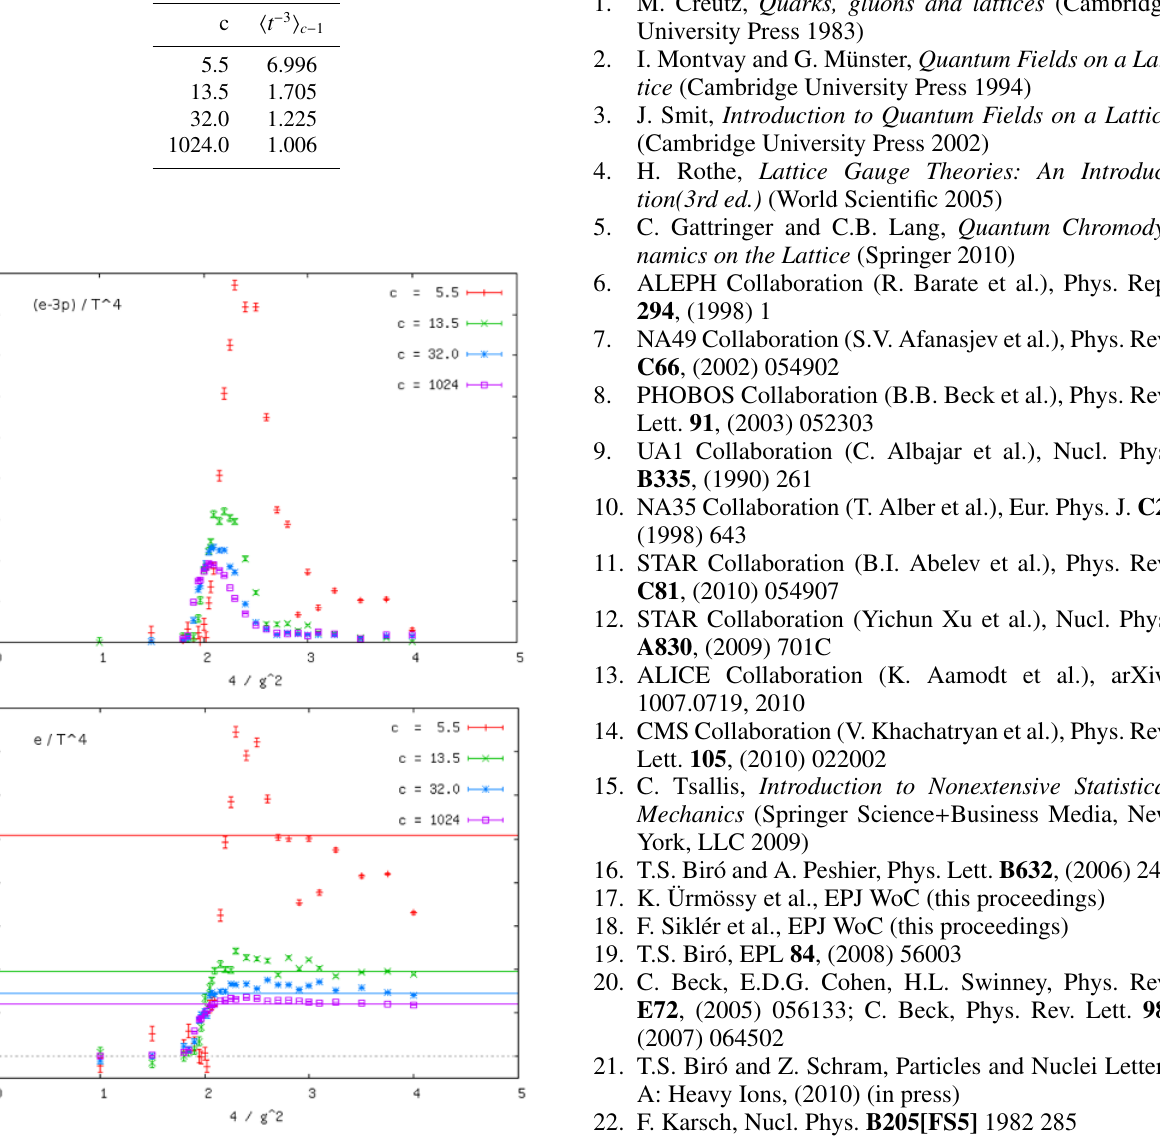
Table 1. Factors in the Stefan-Boltzmann relation for the free Tsallis gas (see equation (18)) at di ff erent c values.